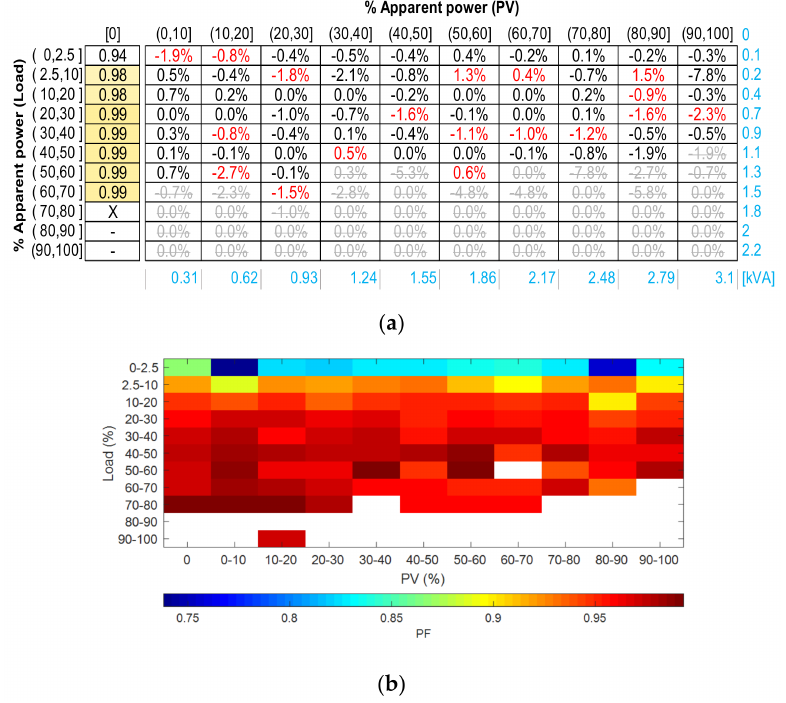
Figure 23. Behaviour of power factor: ( a ) matrix of power factor values for PVS Of f scenarios and variations of power factor values for PVS On scenarios of Phase A, and ( b ) average value per